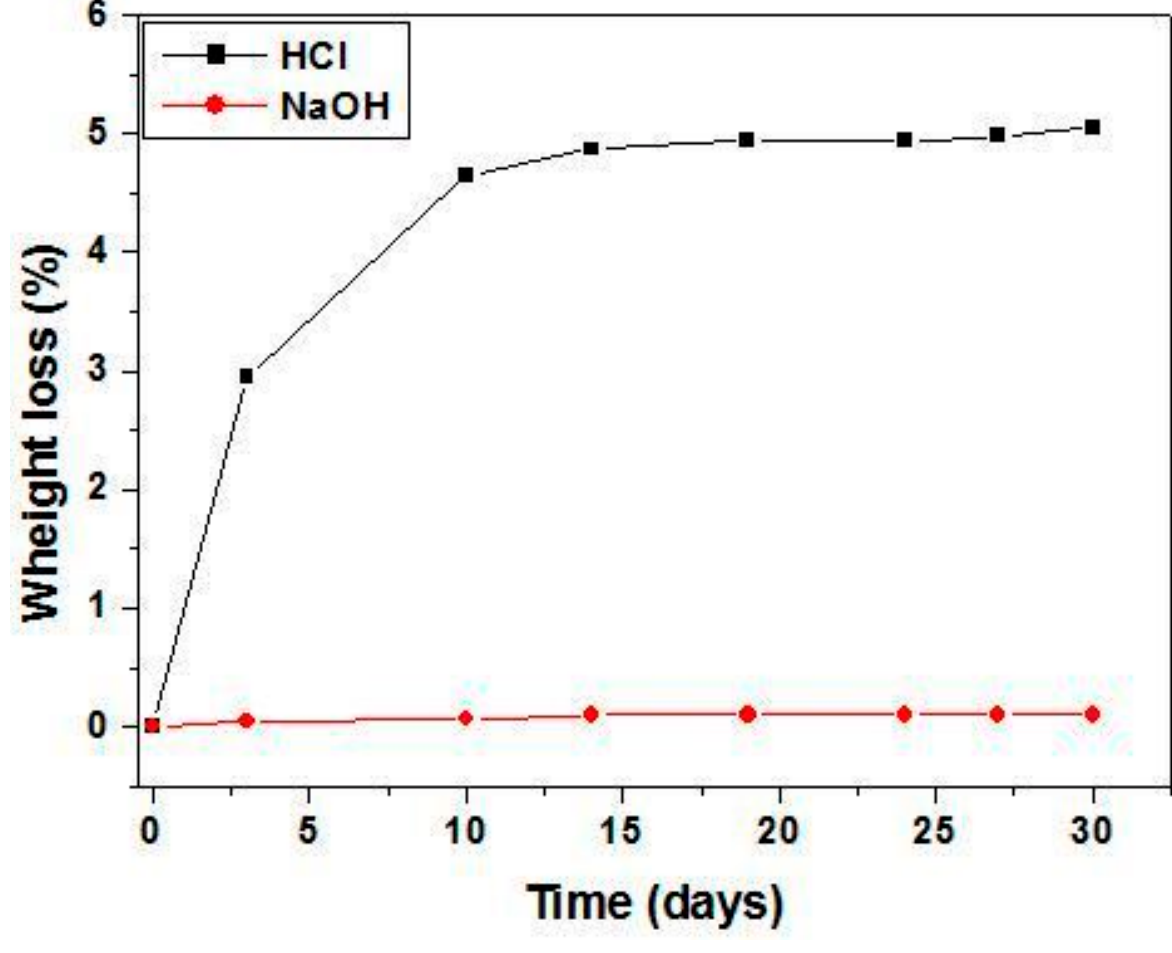
Figure 10. Weight loss of supports sintered at 1250 °C in the basic (NaOH) and acidic (HCl) solutions as a function of time.